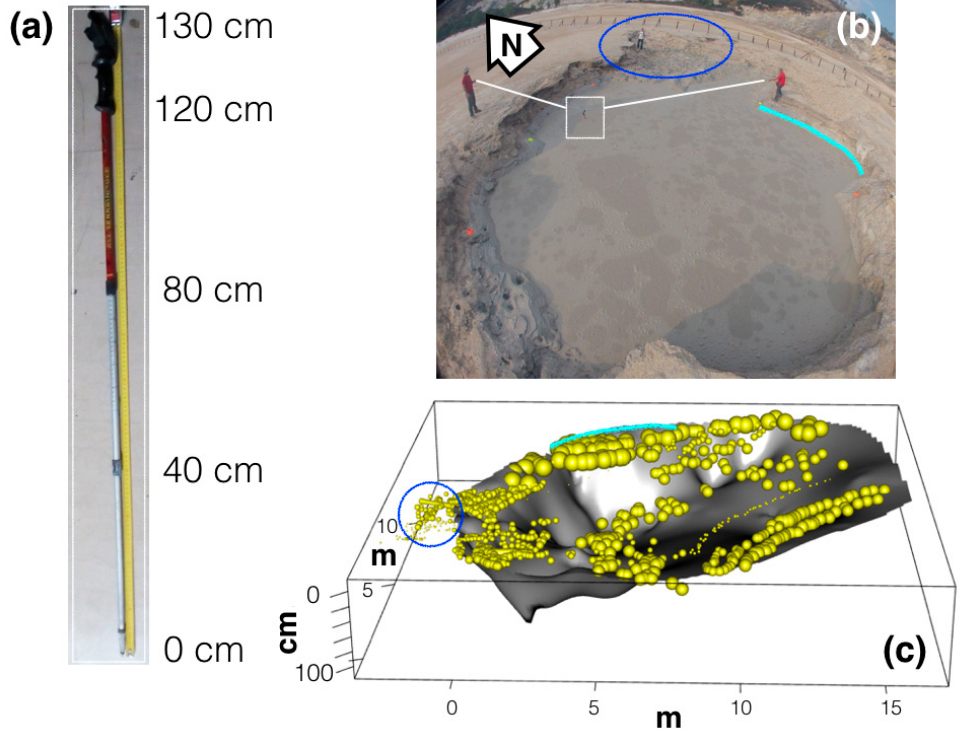
Figure 6. Bathymetry measurements (#61) lowering a scaled walking stick ( a ) attached to ropes from opposite sides of the Fangaia ( b ). ( c ) The resulting bathymetric model as a 3D sketch. The turquoise line in ( b , c ) indicate the same shore. The blue ellipse (in ( b )) and circle (in ( c )) indicate the dry degassing area. The CO 2 flux at the degassing (water-free) shores of Fangaia is directly measured using an accumulation chamber [31] equipped with an infrared detector LICOR-LI-820 (LI-COR Biosciences, Lincoln, NE, USA) (Figure 7). These areas are included in the MultiGAS measurements to obtain CO 2 and H 2 S concentrations and ratios over areas una ff ected by